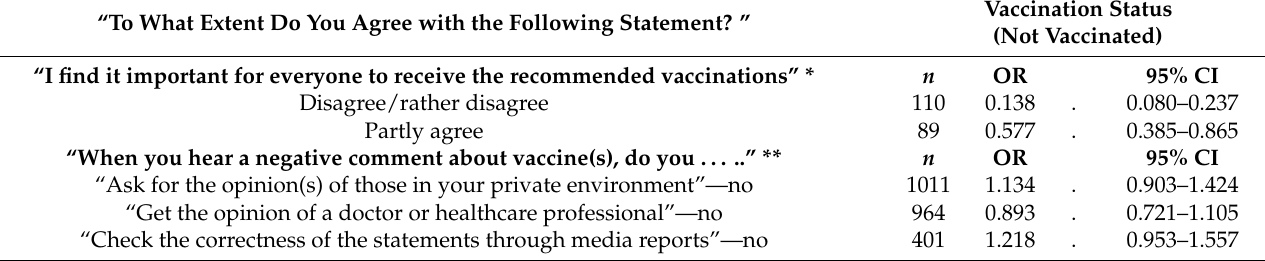
Table 4. Binomial logistic regression of attitudes towards vaccinations associated with negative COVID-19 vaccination